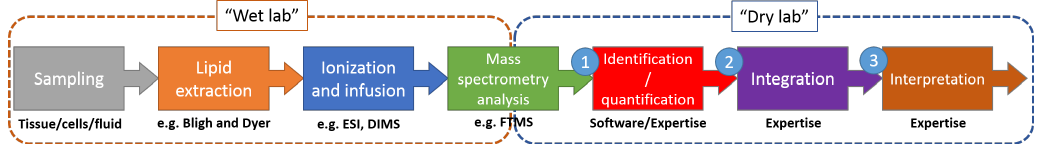
Figure 1: The lipidomics workflow from a sample to an interpretation in the context of integrated omics analyses. The numbers inside the ”Dry lab” box indicate the different frontiers in compu- tational lipidomics as presented in this section and throughout this